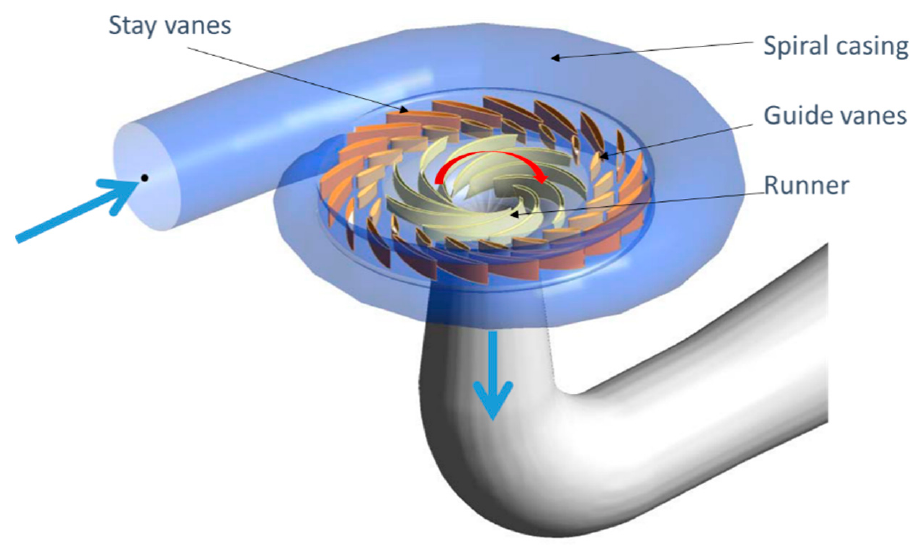
Figure 1. Main components of a reaction hydraulic turbine.